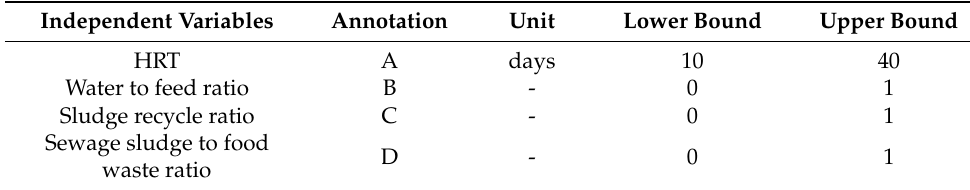
Table 3. Upper and lower bound limits of the independent